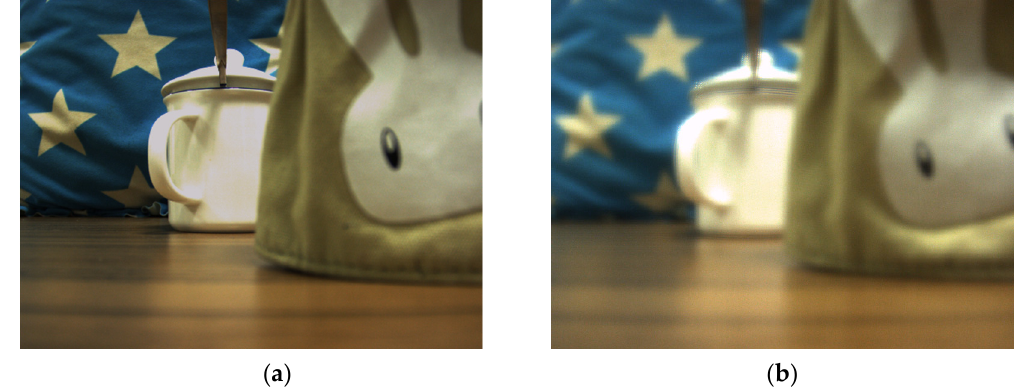
Figure 9. The light field imaging based on the proposed LC microlens under different voltages of the external electric field: ( a ) is at 0 Vrms; ( b ) is at 2.0 Vrms.